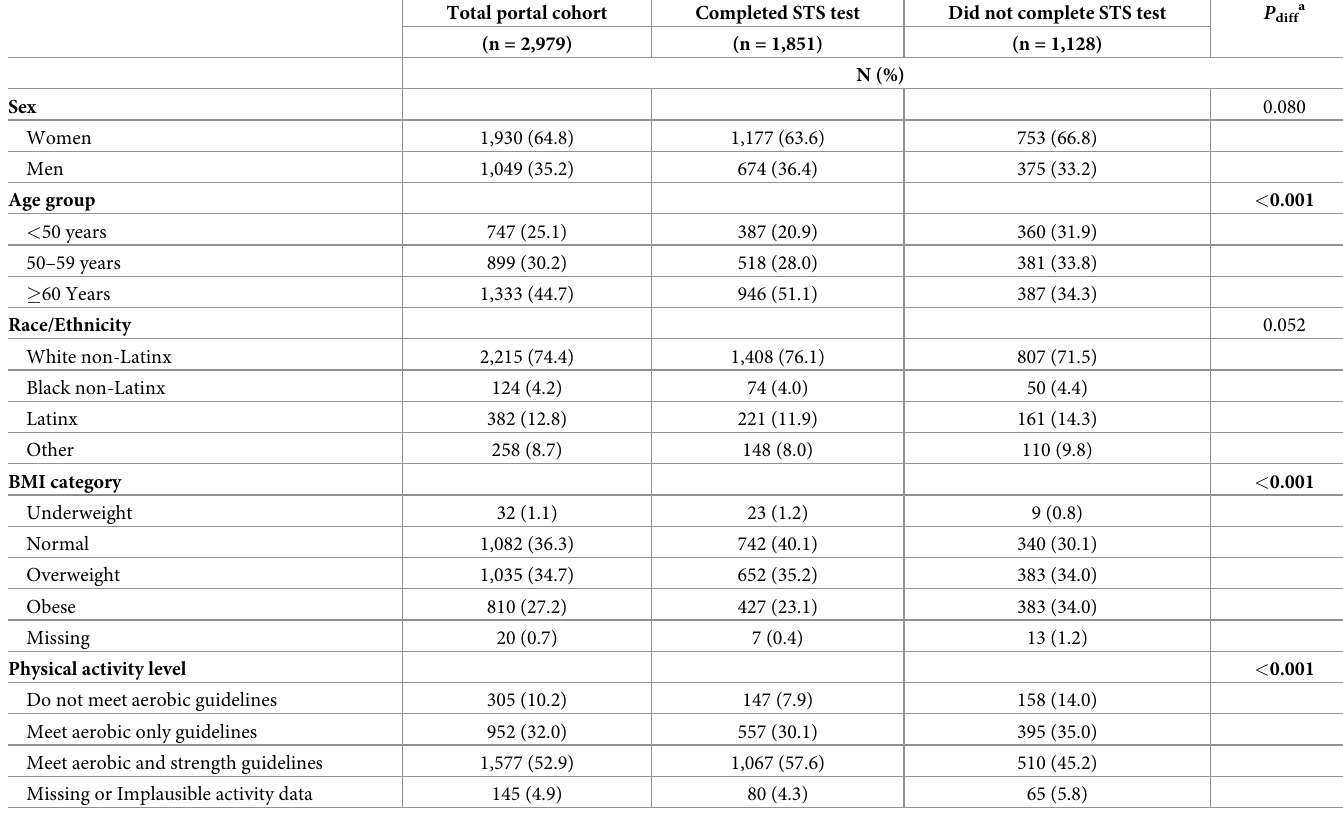
Table 1. Demographic characteristics of CPS-3 portal participants by sit-to-stand test